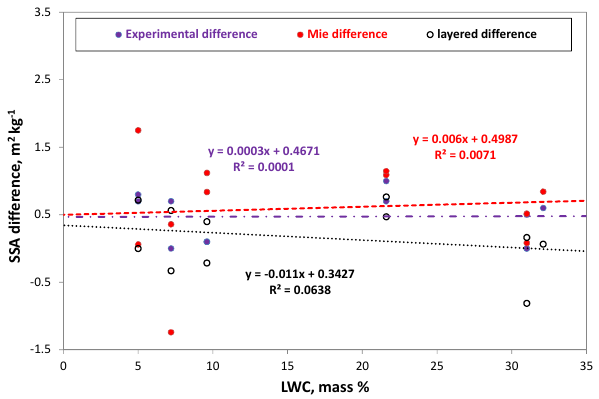
Figure 8. SSA differences between frozen and wet samples from measurements (purple) and estimated with models calculations with Mie (red) and the layered code